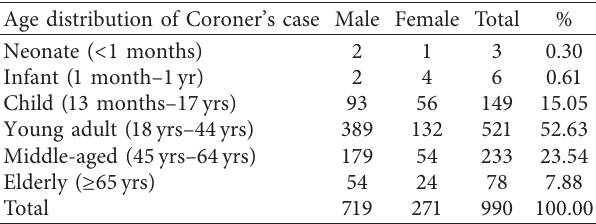
Table 2: Age distribution of Coroner’s cases and their gender. Age distribution of Coroner’s case Male Female Total